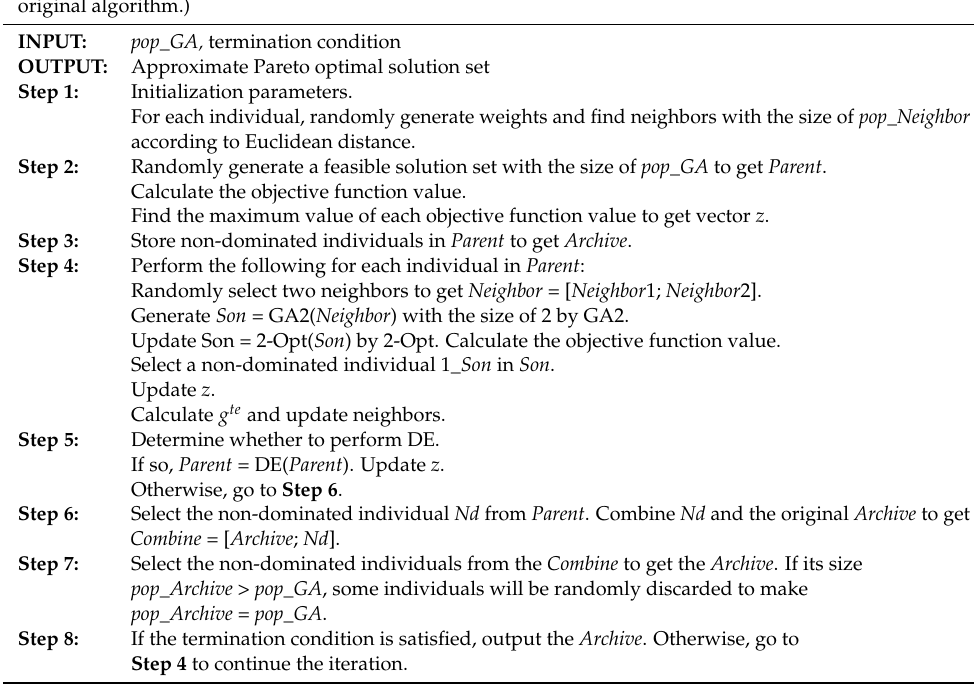
Algorithm 3: M2D ( Archive corresponds to EP in the original algorithm. 1_ Son corresponds to y (cid:48) in the original